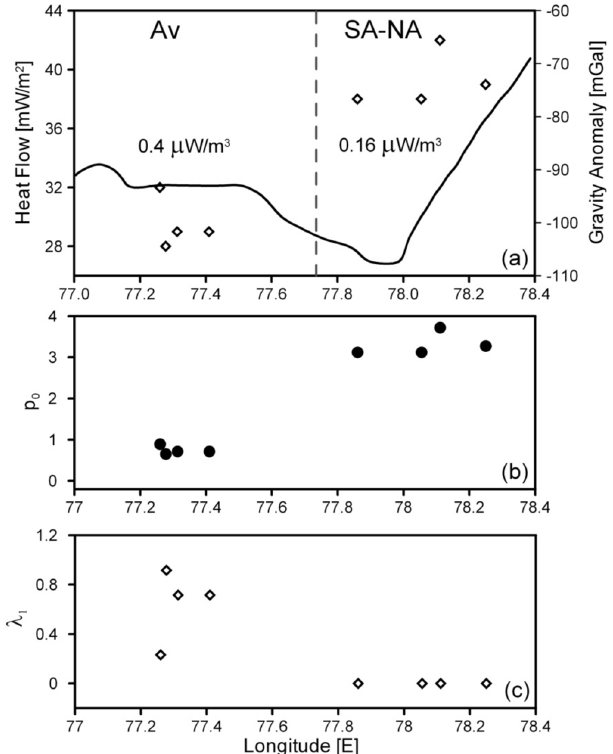
Fig. 2. (a) Surface heat flow and heat generation values along with Bouguer gravity anomaly for PCSZ (from Manglik, 2006), and cor- responding values of (b) p 0 and (c) λ 1